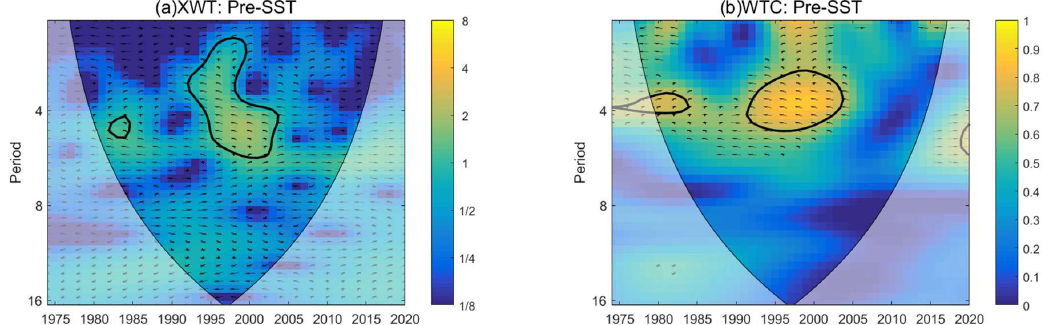
Figure 11. XWT of precipitation and SST in the tropical western Indian Ocean. ( a ) energy spectrum; ( b ) condensation spectrum.